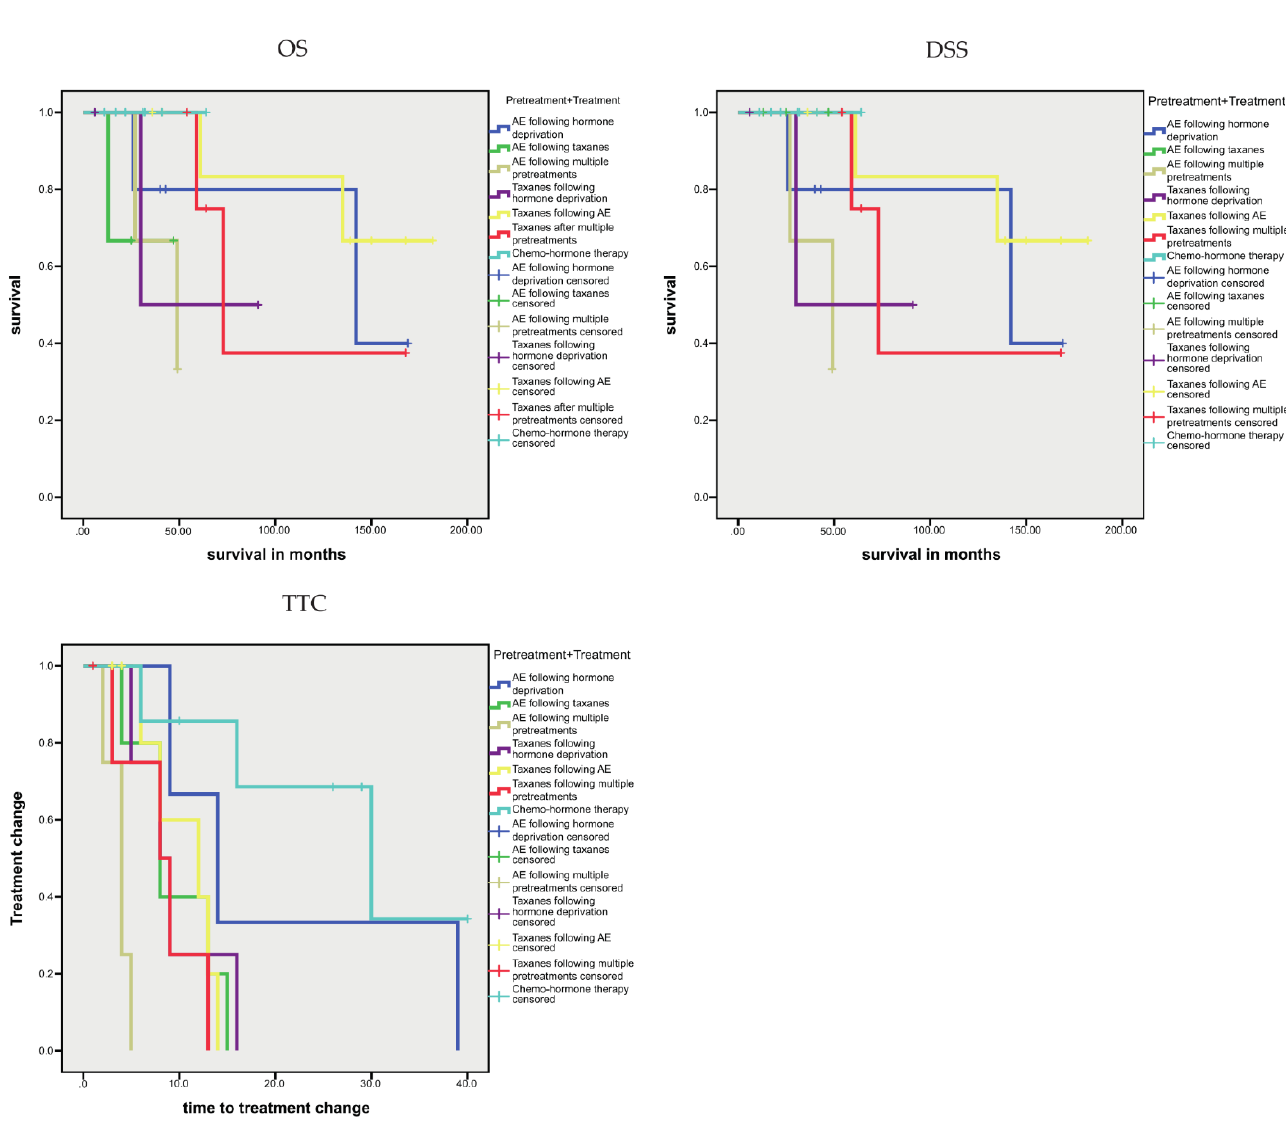
Figure 1. Kaplan–Meier analysis: association of pretreatment–treatment groups with prognosis (OS, DSS, TTC). Figure 1. Kaplan – Meier analysis: association of pretreatment – treatment groups with prognosis (OS, DSS, TTC).